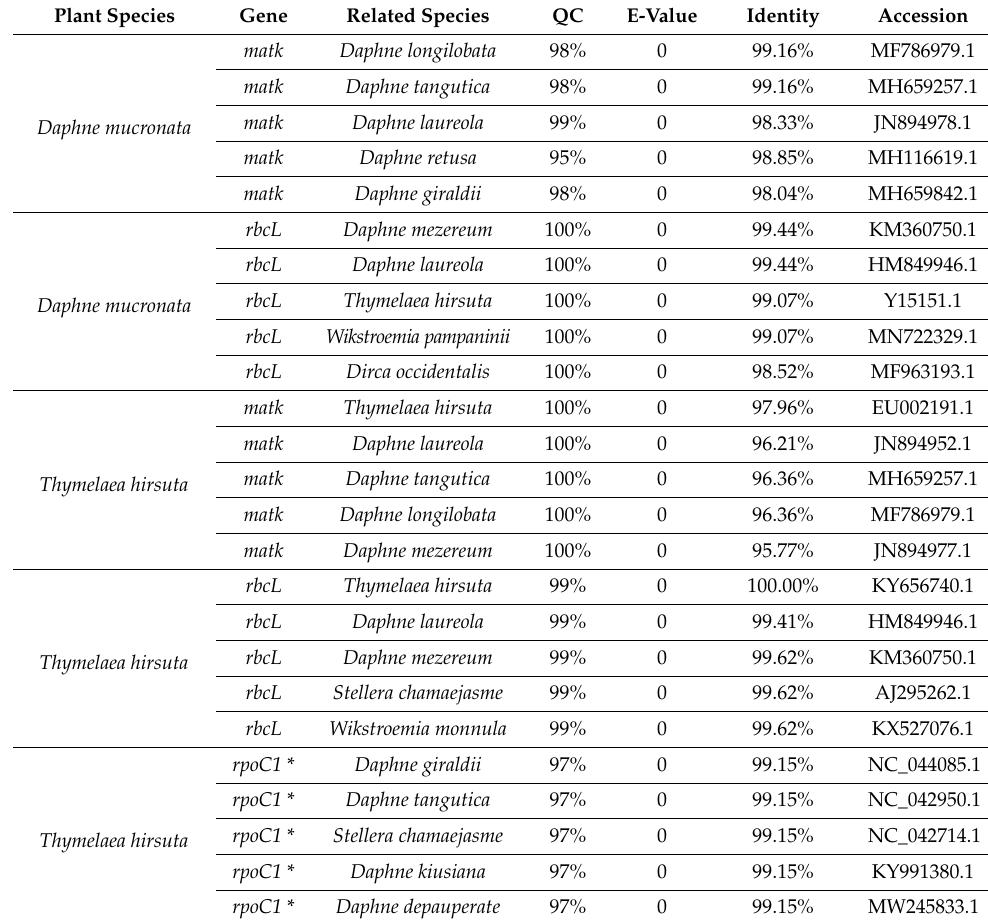
Table 2. The NCBI-BLAST results retrieved sequences of different species related to Daphne mu- cronata, sequence coverage (QC), E value, identity percentage, and retrieved